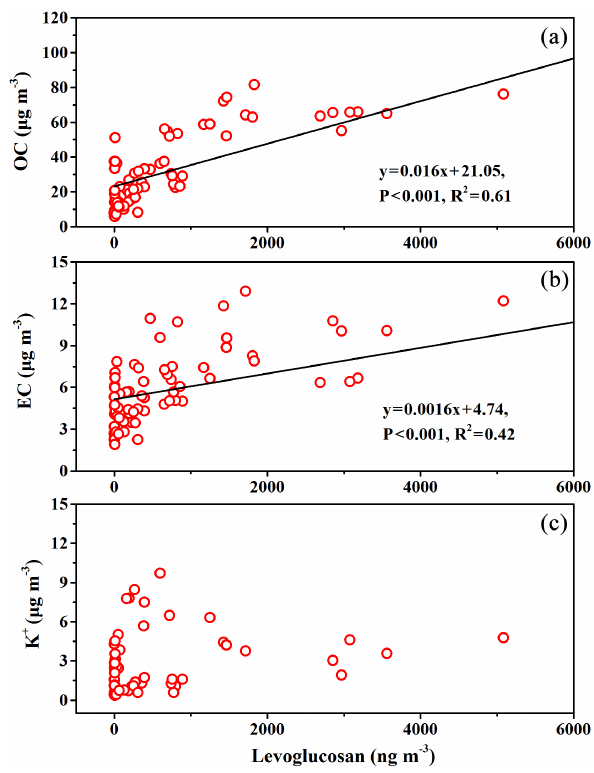
Figure 6. Correlations between (a) levoglucosan and OC, (b) lev- oglucosan and EC and (c) levoglucosan and K + during the whole